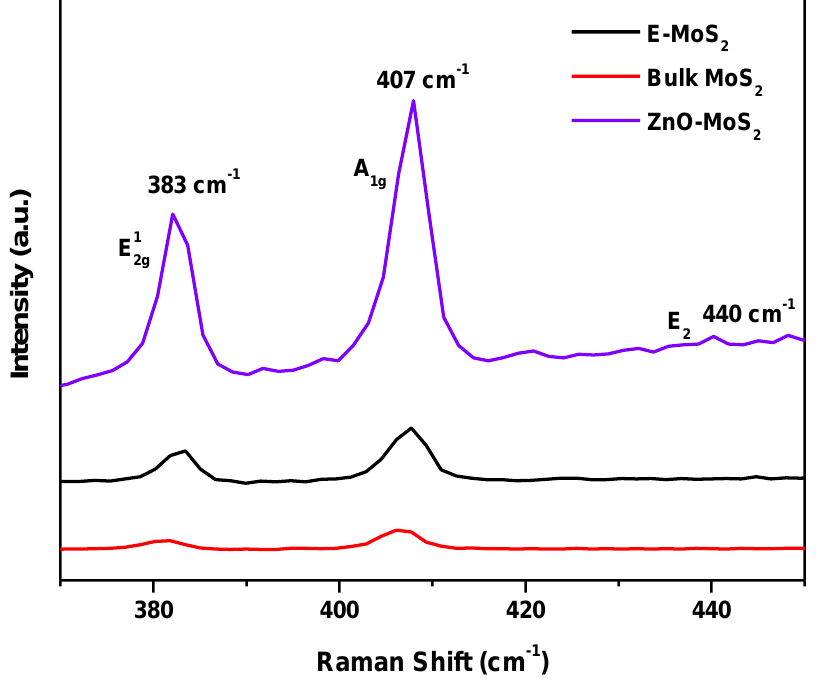
Figure 4. Raman spectra of the bulk MoS 2 , E-MoS 2 and hybrid ZnO-MoS 2.